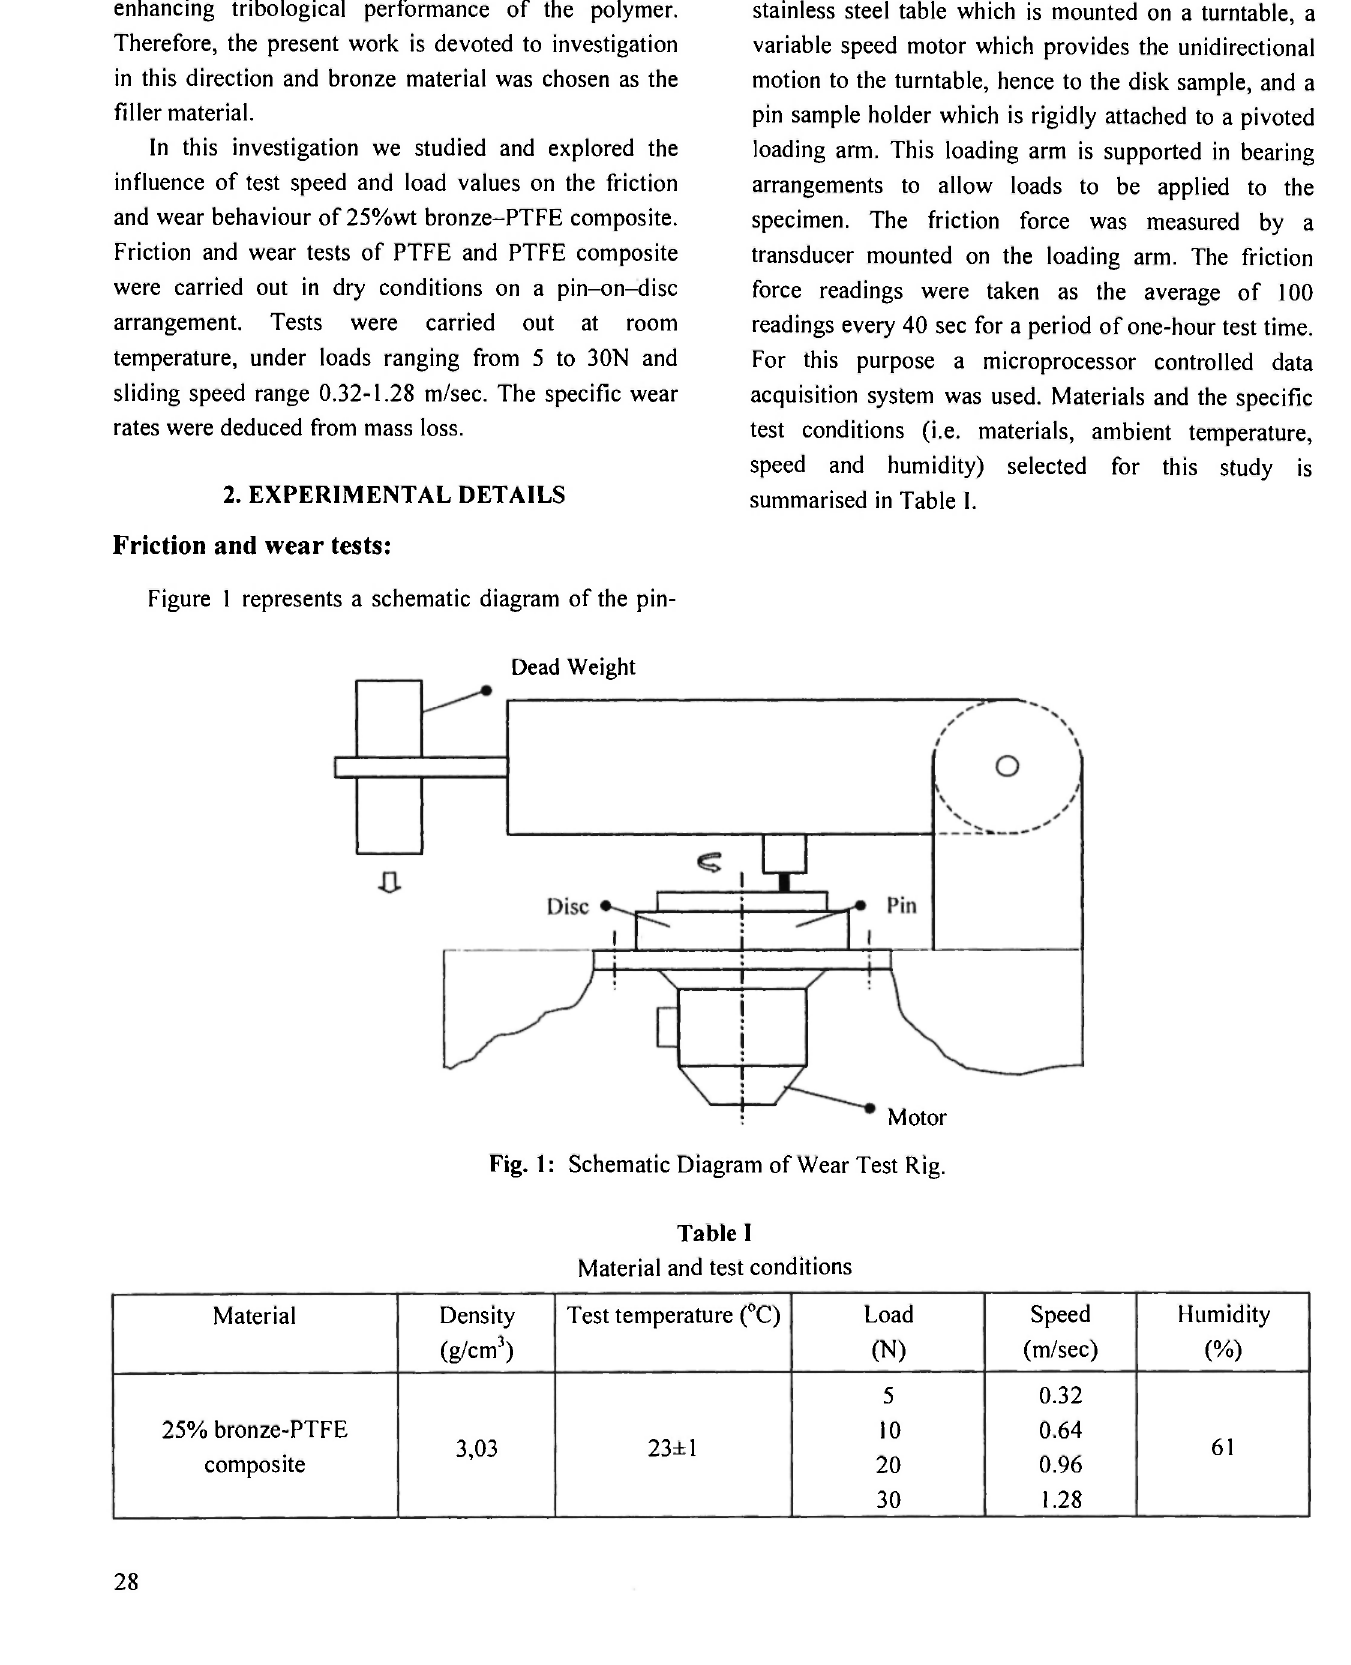
Fig. 1 : Schematic Diagram of Wear Test